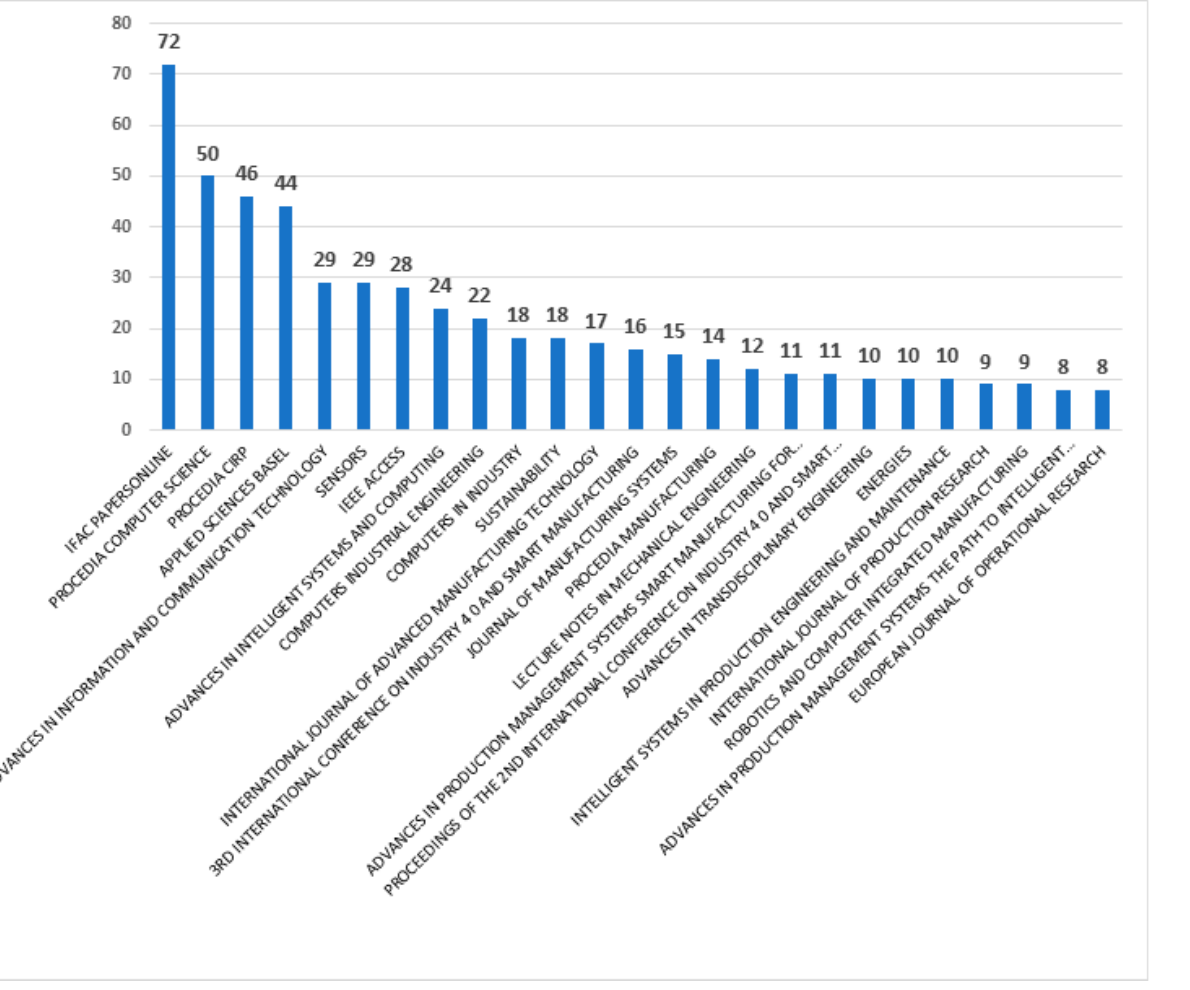
Figure 11. Publication titles in which the Maintenance 4.0 research area papers were the most frequently published (for the Web of Science database).